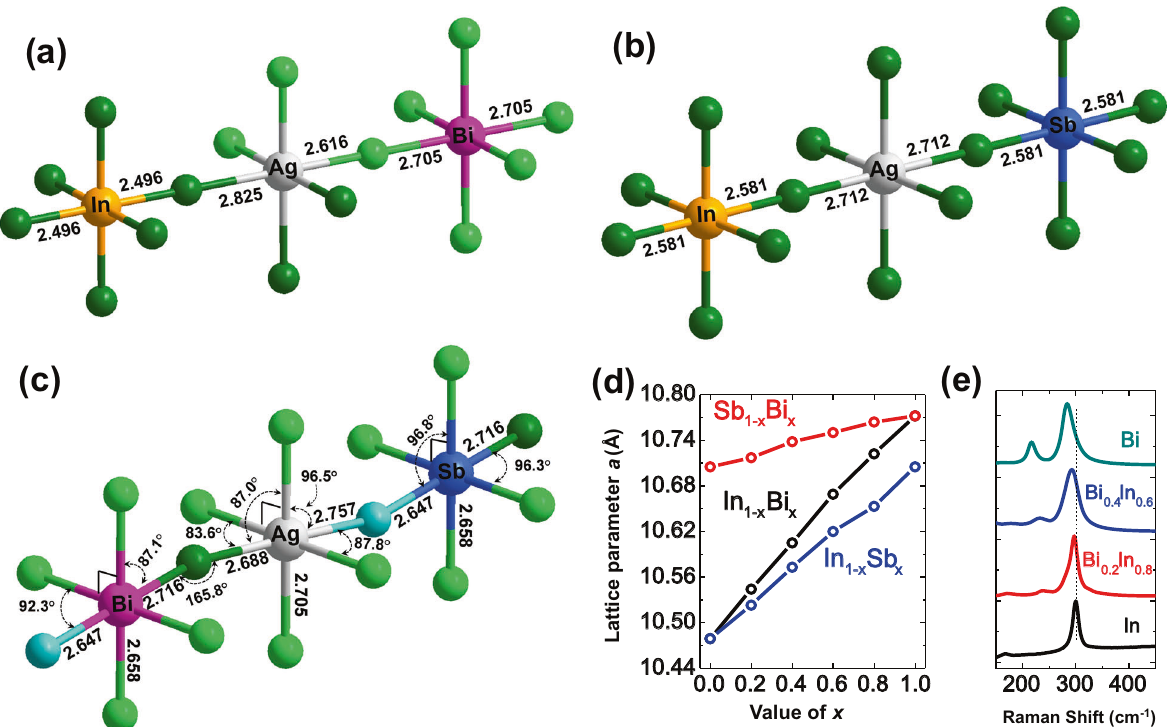
Fig. 1 Structural characterization of halide double perovskite compounds. Single crystal X-ray structures: octahedral arrangements in ( a